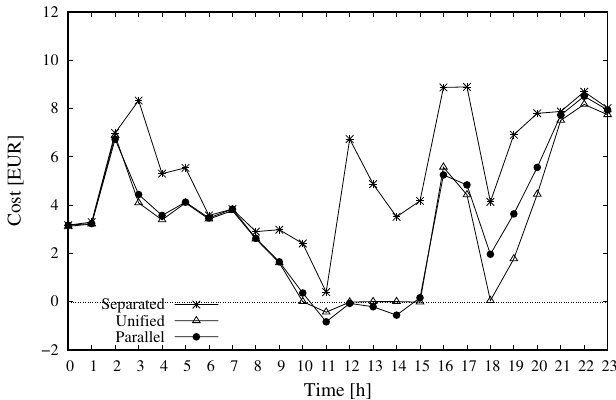
Figure 7. Daily cost profile of the community considering the energy exchanged with the external grid. Comparison among the Separated, the Unified, and the Parallel approach. Table 6. The daily cost and execution time for a community of 100 users. Separated Unified Parallel daily cost EUR